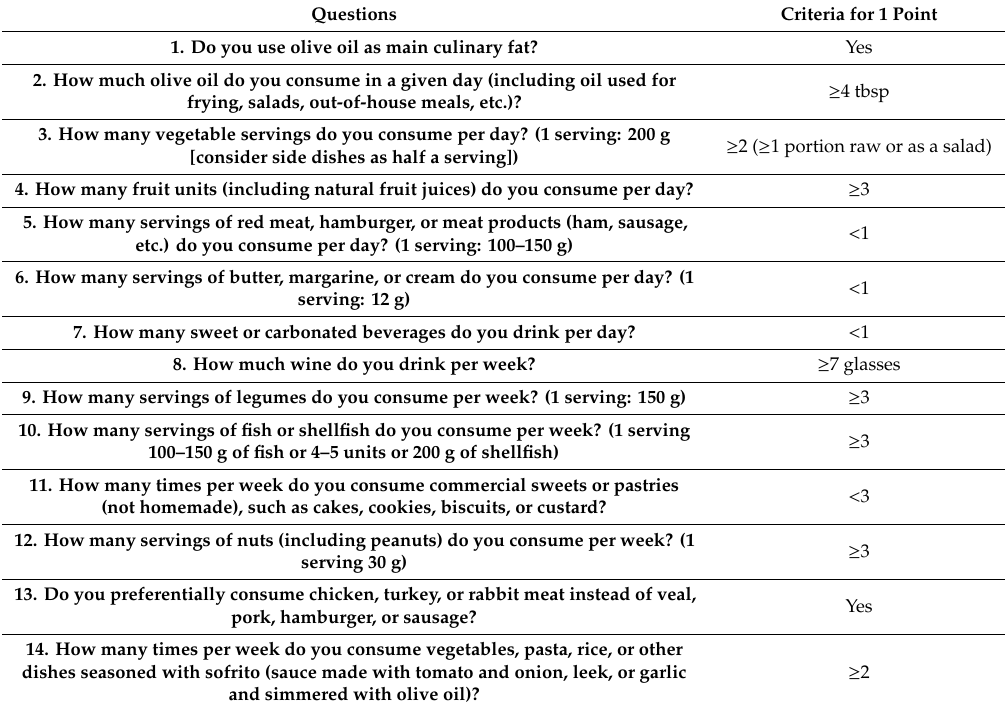
Table A1. Self-administered questionnaire for the assessment of the adherence to the Mediterranean diet (from Mart í nez-Gonz á lez, M.A.; Garc í a-Arellano, A.; Toledo, E.; Salas-Salvad ó , J.; Buil-Cosiales, P.; Corella, D.; Covas, M.I.; Schröder, H.; Ar ó s, F.; G ó mez-Gracia, E. et al., A 14-item Mediterranean diet assessment tool and obesity indexes among high-risk subjects: The PREDIMED trial. PLoS One 2012, 7). Questions Criteria for 1